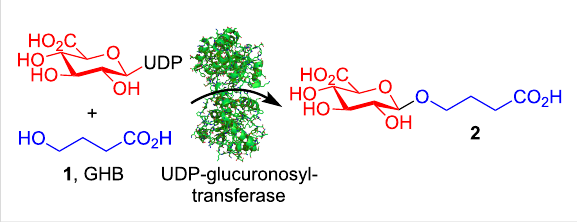
Figure 1: Hypothesised glucuronidation of GHB ( 1 ) by UDP- glucuronosyltransferase to give glucuronide 2 . UDP = Uridinediphos-